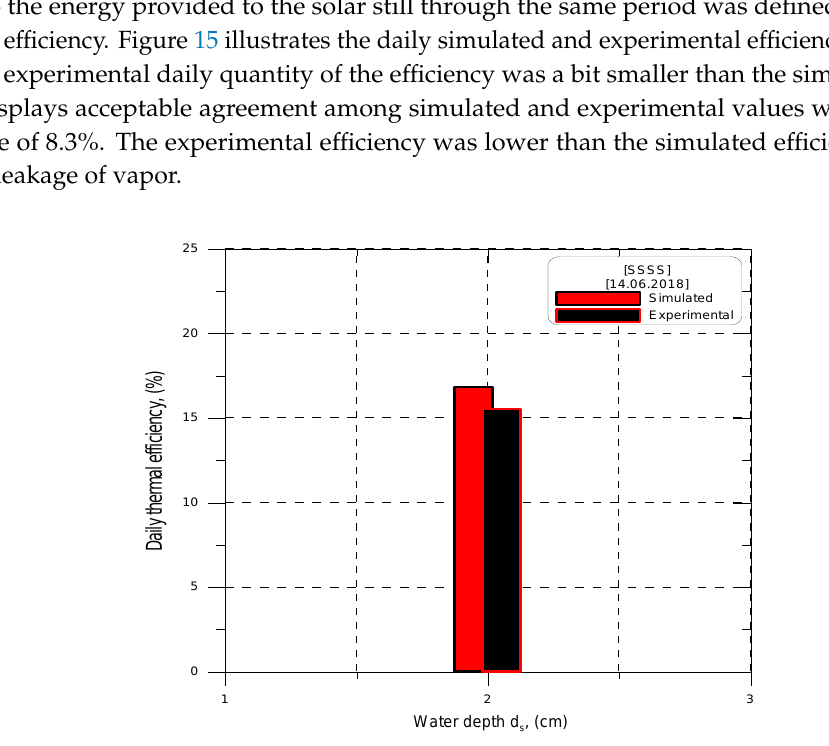
Figure 15. The simulated and experimental daily efficiencies of the studied still with a water depth of 2 cm.